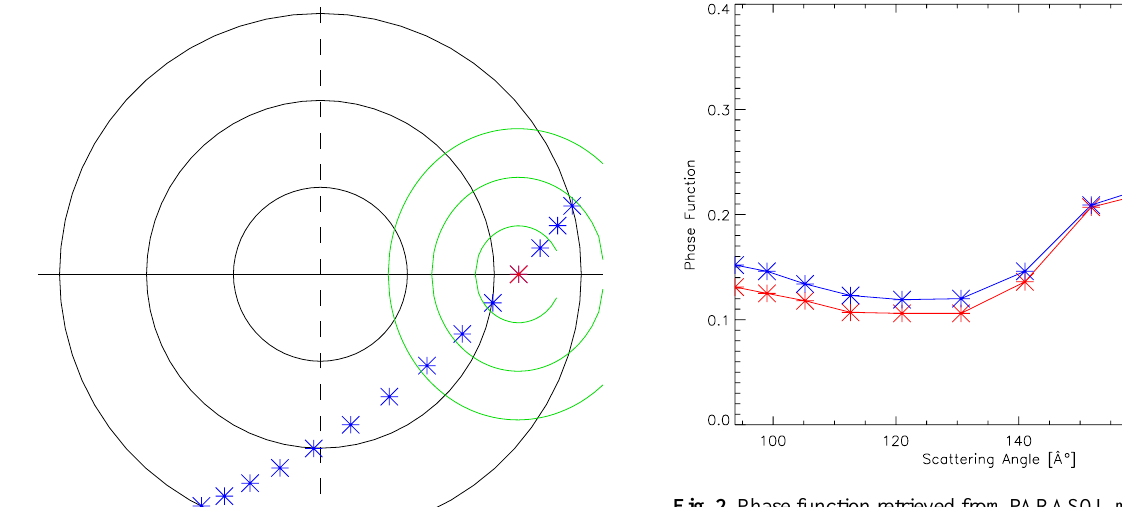
Fig. 2. Phase function retrieved from PARASOL measurements for the same pixel as in Fig. 1. Red (blue) is for the 670nm (865nm) band. Note that, for the largest scattering angles, there are two mea- surements for similar values of the scattering angle. These corre- spond to measurements acquired before and after the backscatter